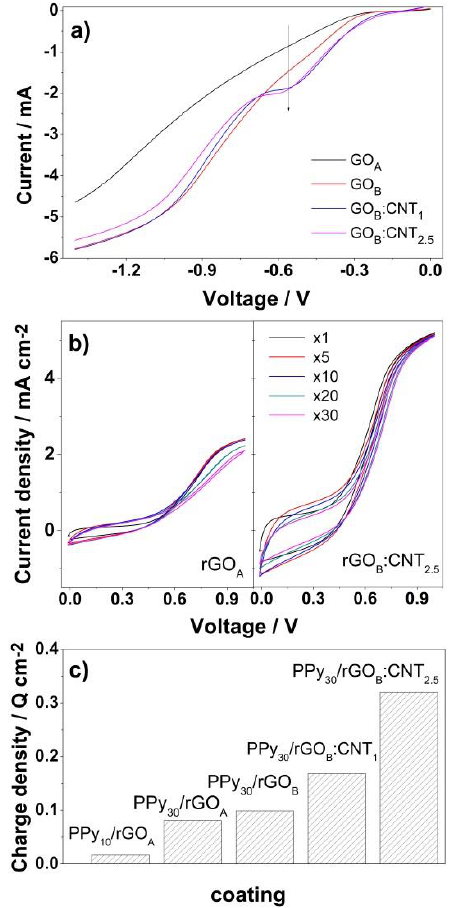
Figure 1. Cathodic scans of GO-modified substrates (V vs. Ag/AgCl) ( a ); voltammogram evolution for polypyrrole (PPy) electrodeposition with substrate and number of cycles (V vs. Ag/AgCl) ( b ); evolution of PPy deposition charge density as a function of loading cycle number (10 and 30) onto rGO x :CNT y coatings ( c